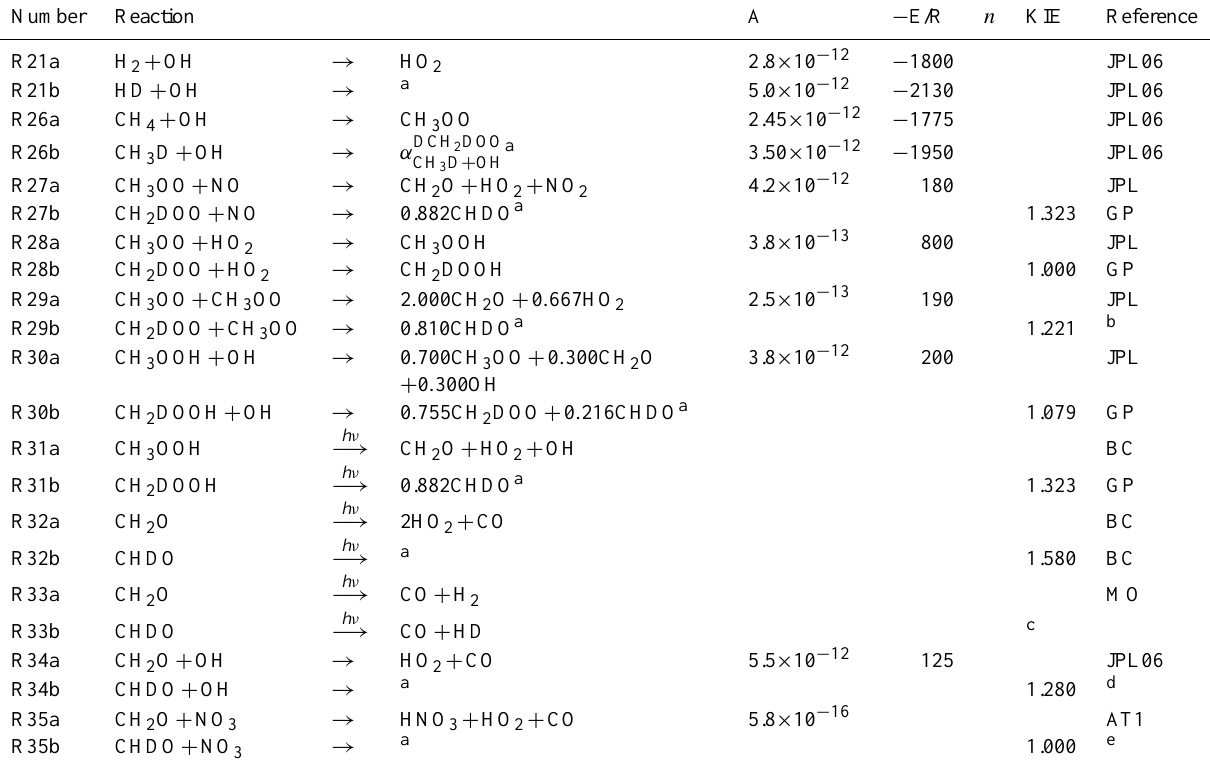
Table A1. Overview of modified CBM-4 reactions related to methane and molecular hydrogen